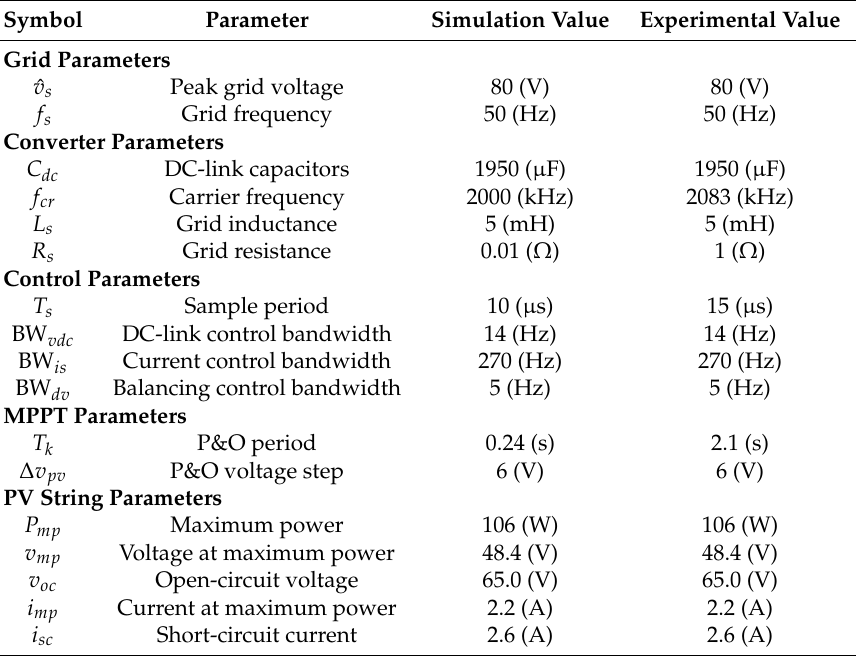
Table 2. Simulation and experimental